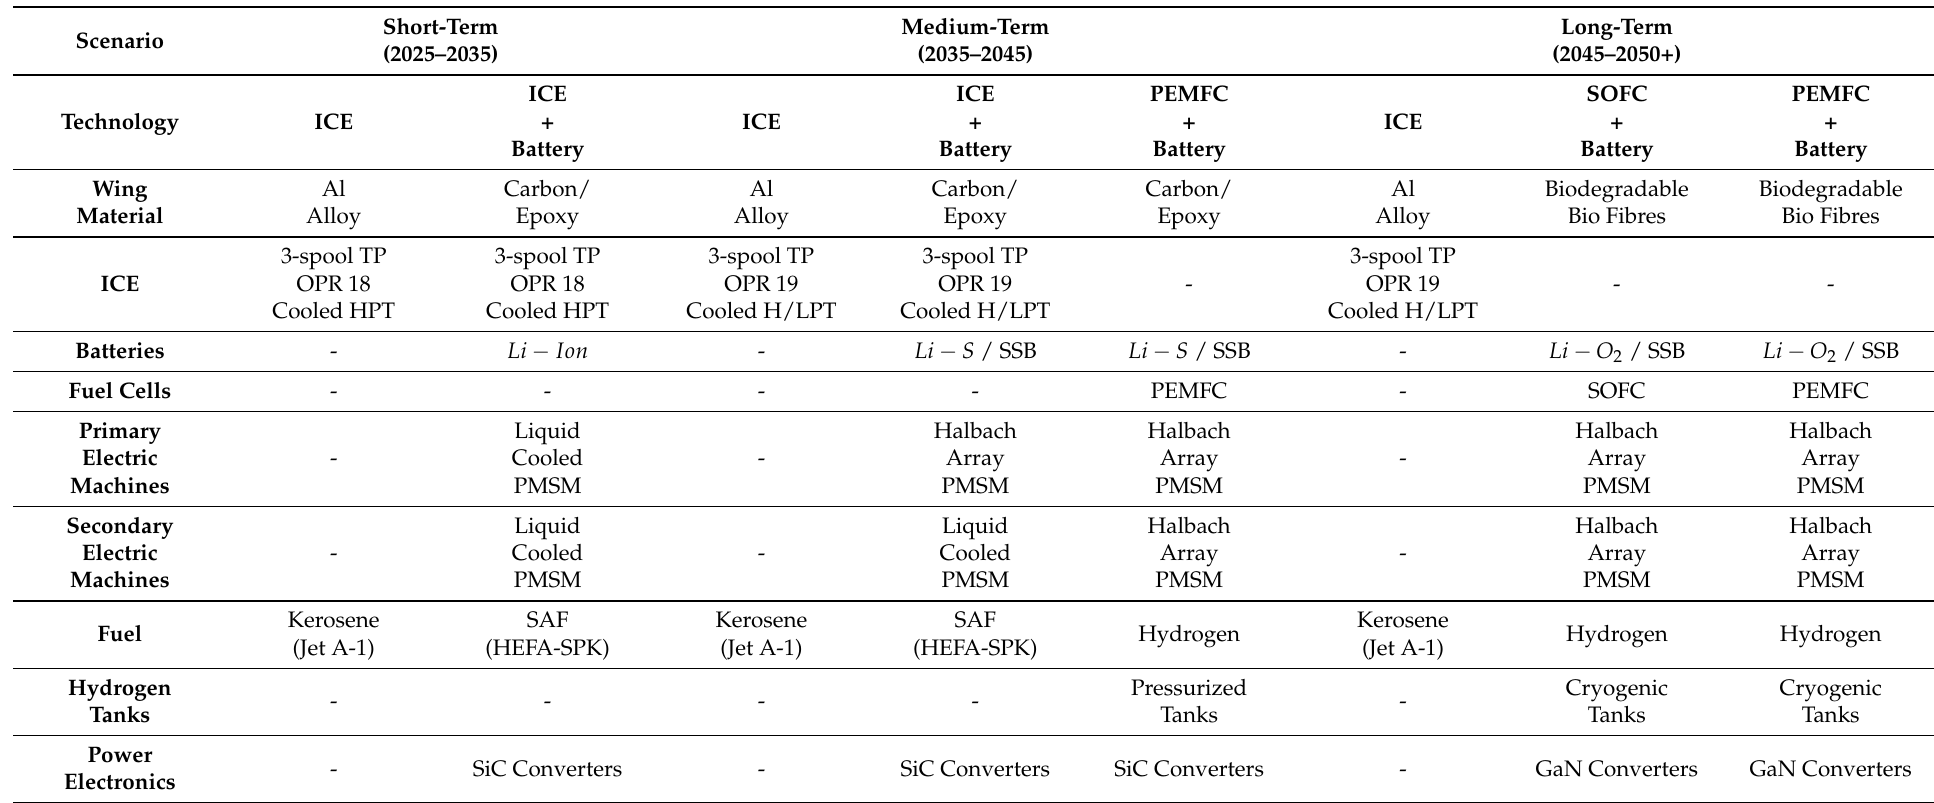
Table 2. Summary table for the technologies implemented for all of the concept models